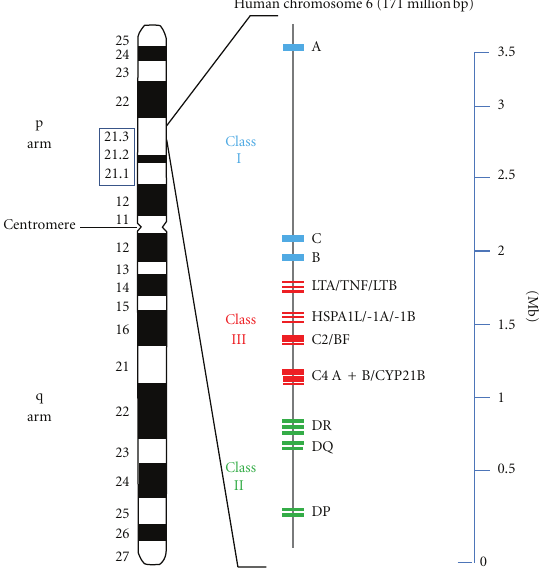
Figure 1: HLA gene cluster and lupus susceptibility genes on human chromosome 6. Ideogram of chromosome 6 (left) and schematic diagram of the MHC-complex-associated genes ranging from 6p21.1 to 6p21.3 (middle). The class I gene complex contains three major loci (A, C, and B), as well as additional (unmentioned) loci. The resulting class I polypeptides associate with the invariable beta-2 microglobulin, encoded by a gene on chromosome 15. The HLA-B locus is known as the most polymorphic gene within the human genome. Class II MHC molecules are composed of two glycosylated polypeptide subunits (called α and β chain) of approximately equal length. Whereas HLA-DP and -DQ code for one alpha- and one beta-chain polypeptide, respectively, the genetics of HLA-DR is more complex: It consists of one locus coding for the alpha subunit and 4 loci coding for beta subunits. Unlike the other DR loci, DRA is not polymorphic. Even though the DR β -chain is encoded by 4 loci, no more than two are present on a single chromosome. DRB1 is the most polymorphic gene of the class II locus. Class I and class II antigens are membrane proteins whereas almost all class III polypeptides are serum proteins (including the complement components C2, C4A, C4B, and factor B) or can be detected in other body fluids. Therefore, the term “class III” is misleading, as this locus does not contain a distinct class of genes. The coding regions of the genes are shown as small blue (class I), green (class II), and red (class II) rectangles,